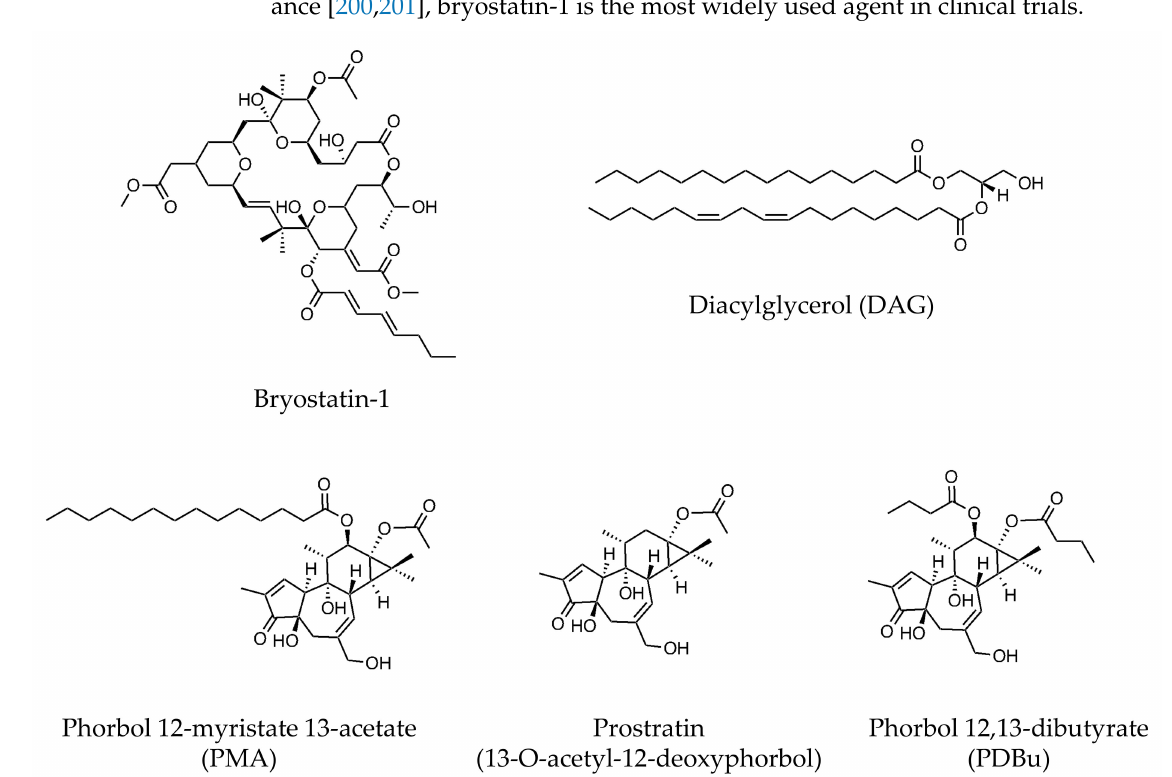
Figure 5. Chemical structure of PKC activators (C1 domain-binding